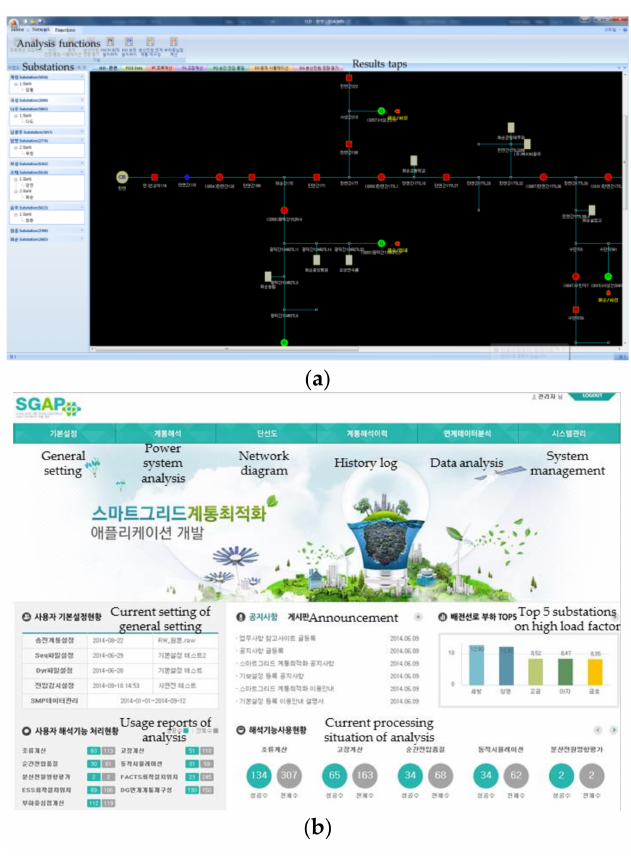
Figure 2. Main menu of the transmission and distribution integrated monitoring and analysis system; ( a ) stand-alone version; ( b ) network